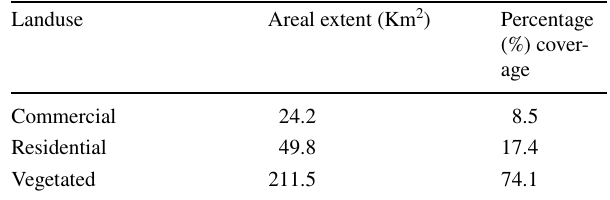
Table 1 NSF water quality